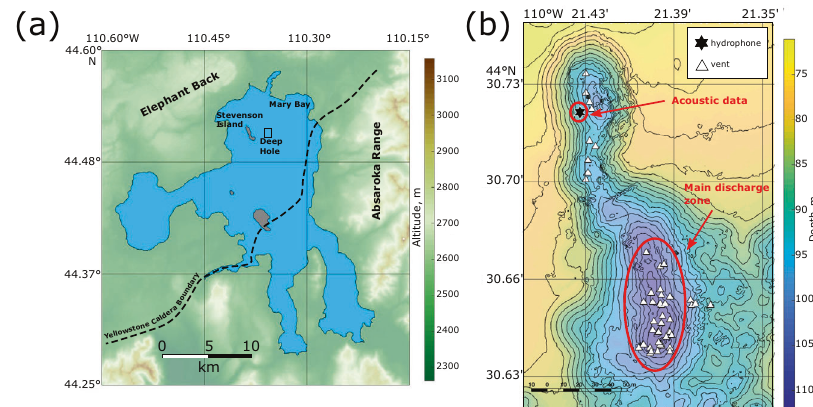
Fig. 1 Location. a Yellowstone Lake (USA). The northern part of the lake lies inside the 640 ka Yellowstone Caldera (dashed line). b Bathymetry of the Deep Hole thermal area (black rectangle in left panel). White triangles indicate active venting locations observed during remotely operated vehicle dives, and the black star corresponds to the hydrophone location. The spatial extent of the main discharge zone is shown with a red